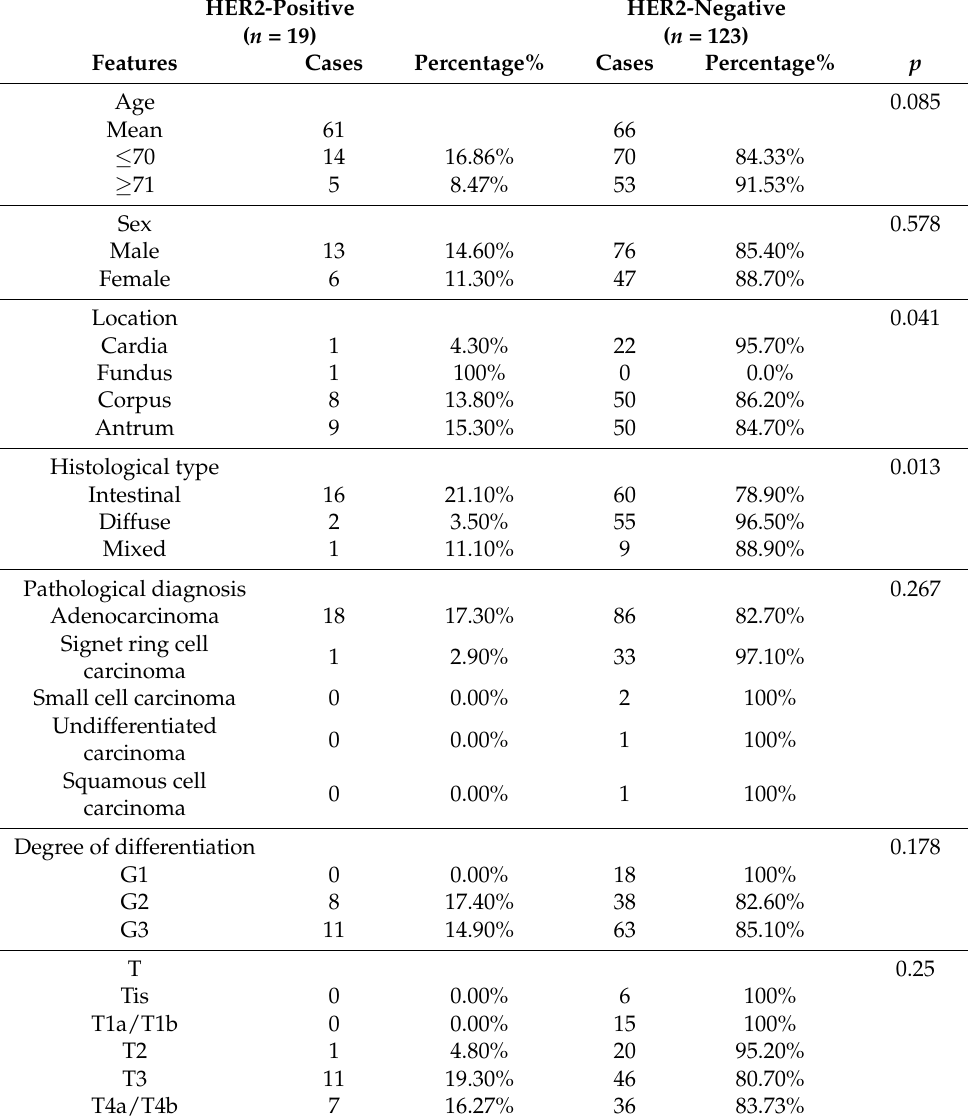
Table 2. Clinical and pathological features of the 142 gastric cancer patients and correlation with HER2